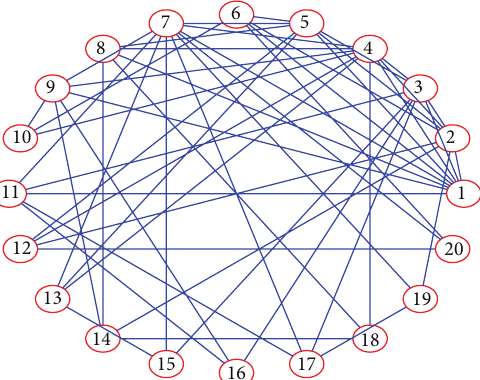
Figure 1: Connection of the closed-loop system.